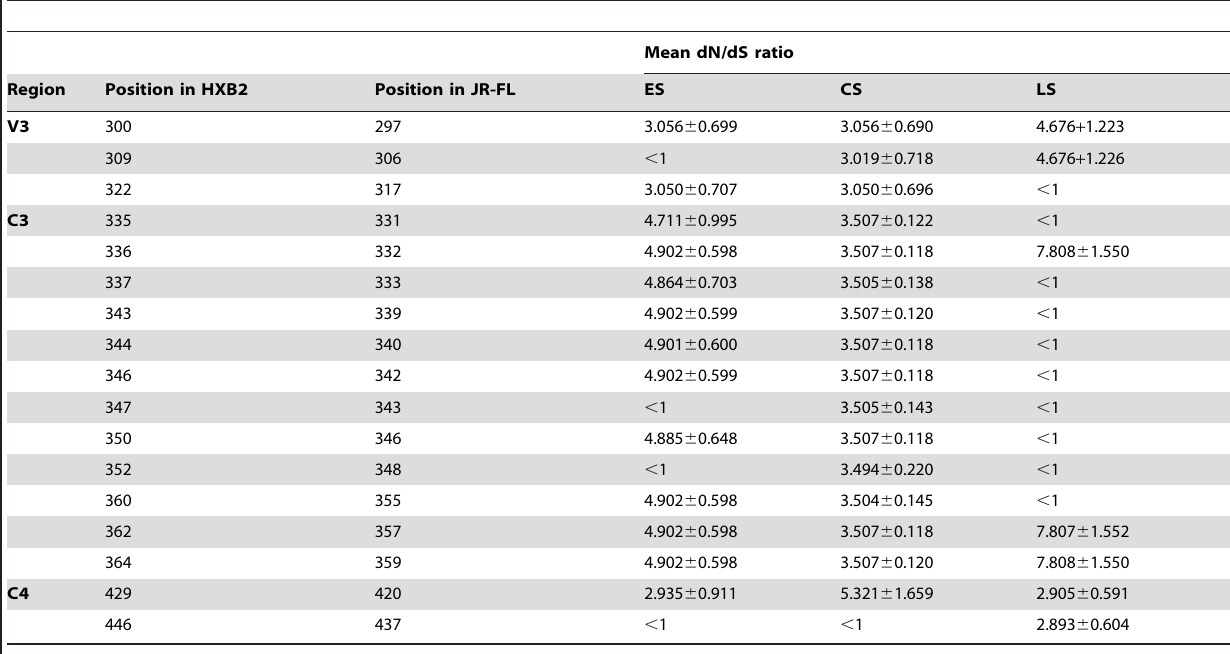
Table 3. Amino acid sites under positive selection in gp120 V3, C3 and C4 regions of HIV-1 clade C variants from patients at different disease